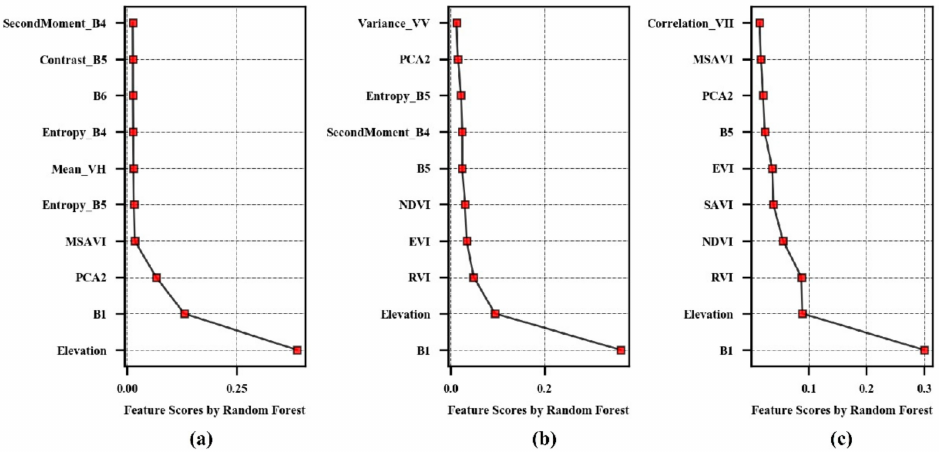
Figure 6. The ranking chart of the optimal 10 variables for forest volume estimation selected using MDG algorithm in RF. The ordinate represents the optimal variable name, and its importance gradually decreases upward ( a )–( c ) denote the result of sample combination field plots (FPs), FPs + VPs ( T = 2 × 10 − 4 ) , and VPs ( T = 2 × 10 − 4 ) , respectively, where B1 represent the blue spectrum band of Landsat-8